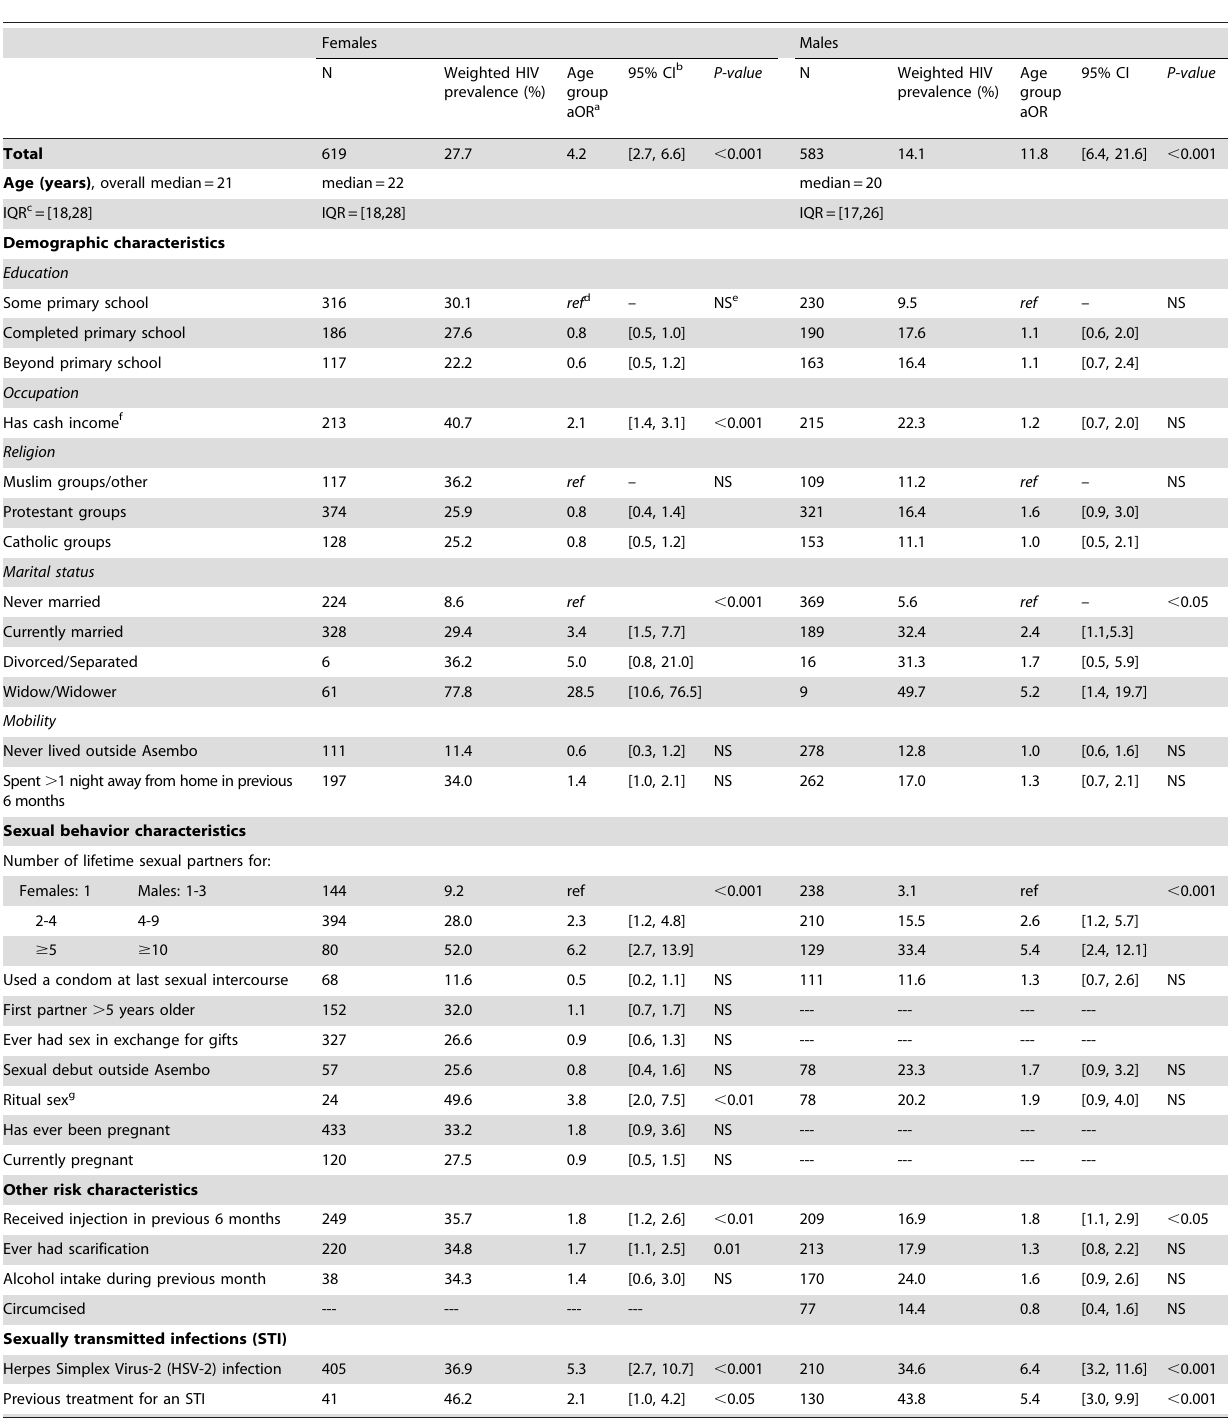
Table 2. Age-group adjusted risk factors associated with HIV infection by gender among sexually active participants, N=1202.